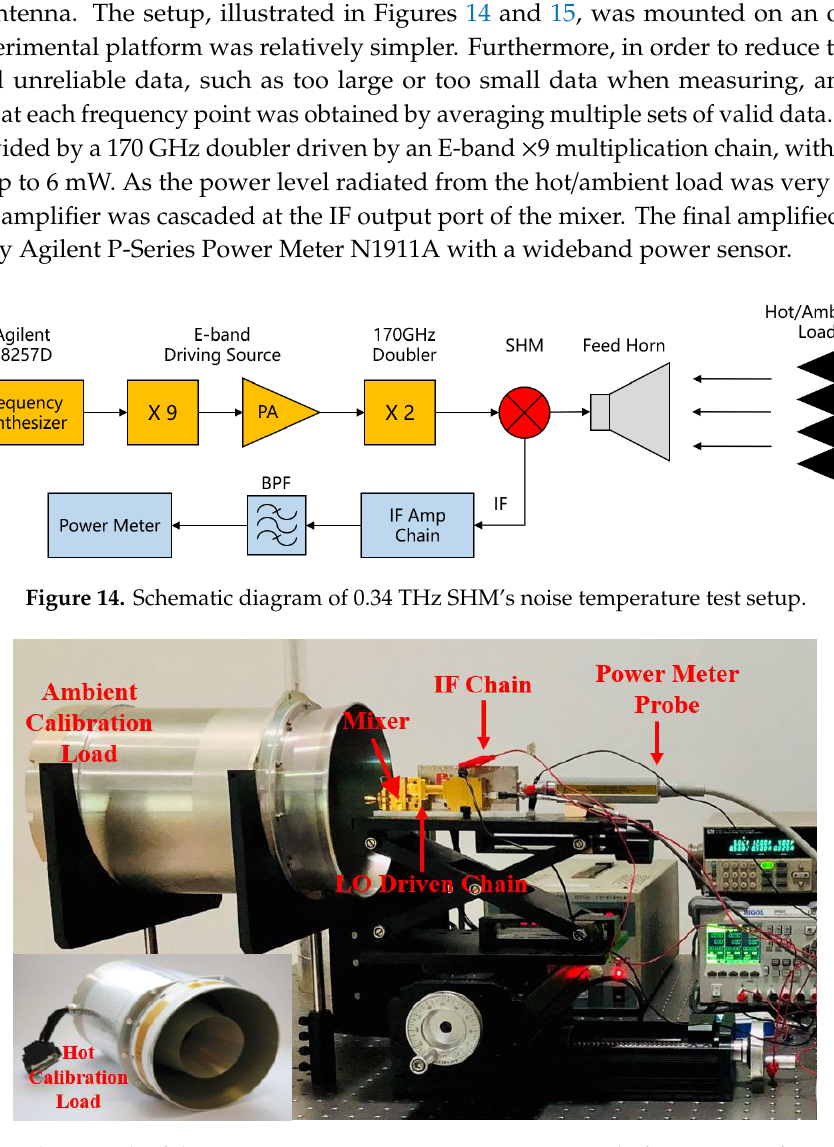
Figure 15. Photograph of the 0.34 THz SHM’s noise temperature test platform using Y-factor method measurement. The ambient/hot calibration load, respectively, radiates broadband noise energy related to real-time temperature into the receiver through feed horn antenna. Every time the calibration load is exchanged the under-test receiver is position fixed.